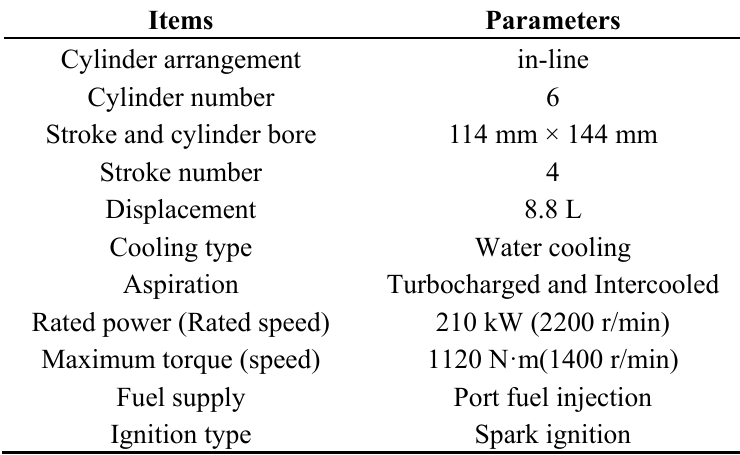
Table 2. The main specifications of the compressed natural gas (CNG)